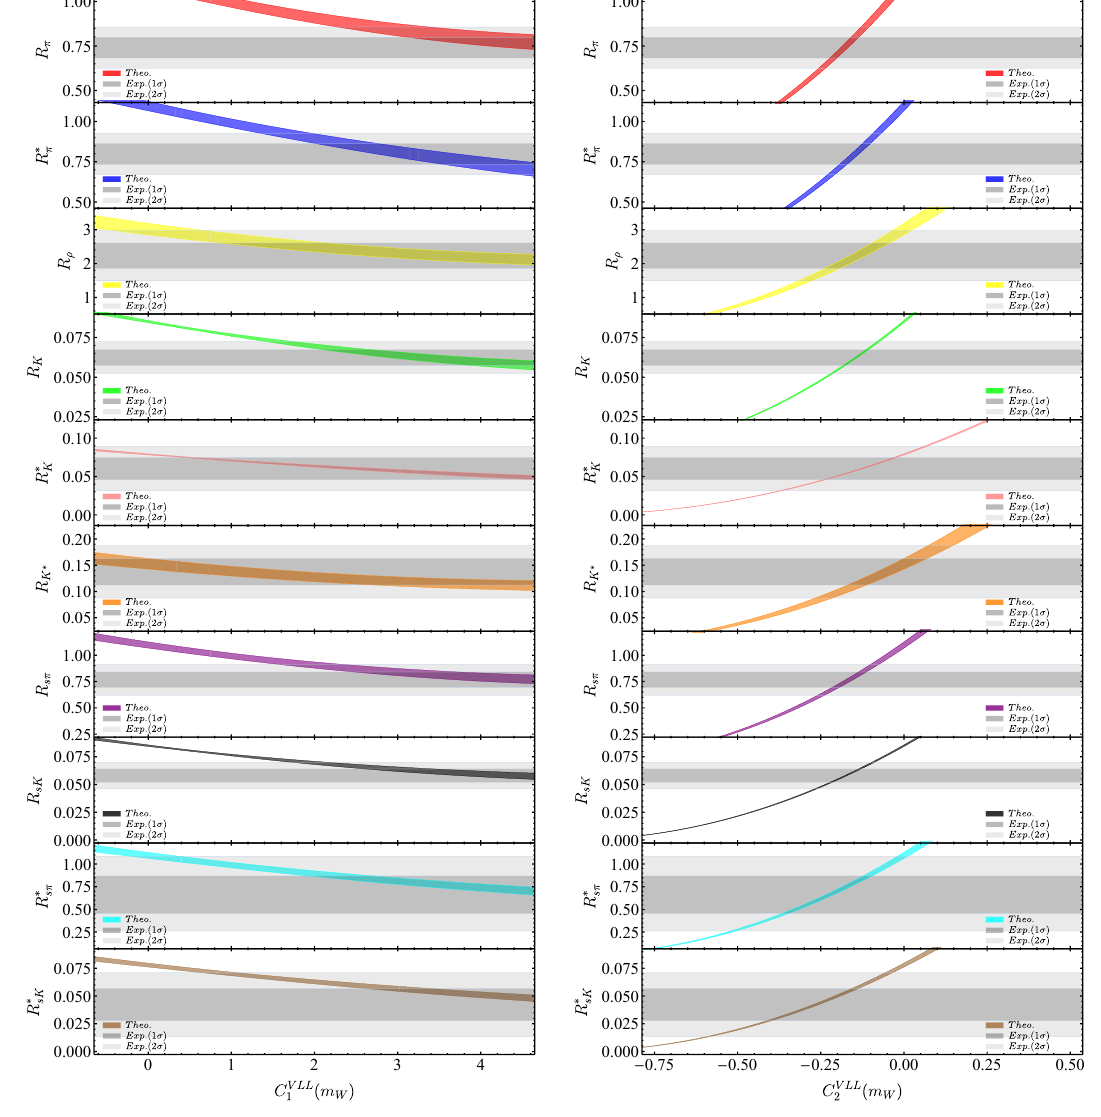
( m W ) (left) and C V LL ( m W ) 1 2